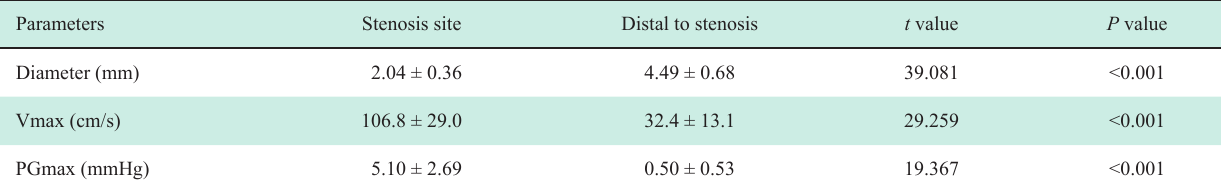
Table 2 Comparison of the diameter and hemodynamic parameters at the stenosis site and the segment distal to the stenosis Parameters Stenosis